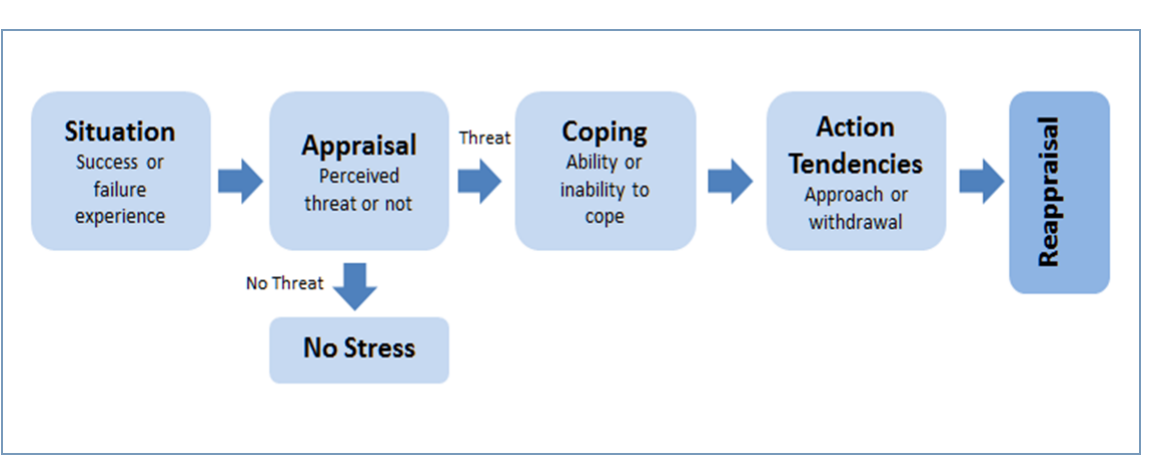
Figure 1. Transactional Model of Stress and Coping adapted from Lazarus and Folkman